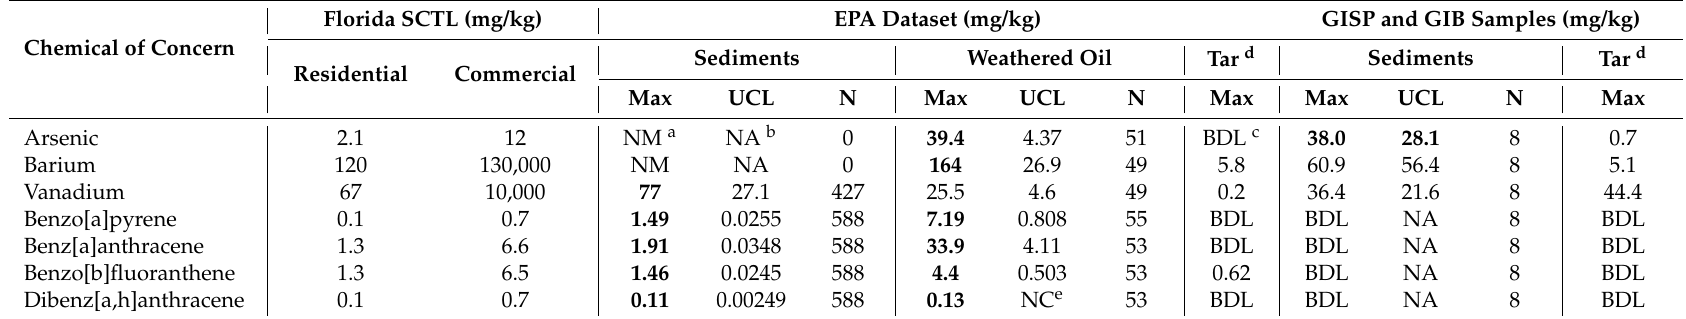
a NM = Not Measured; b NA = Not Applicable; c BDL = Below Detection Limits. BDL values were variable within each chemical category; d UCL were not computed for tar samples because the numbers were too low. Only 2 tar samples were analyzed for metals and only 3 tar samples were analyzed for the organics in the EPA dataset. Only one tar sample was analyzed through the current study; e NC = Not Computed because only one sample was above detection